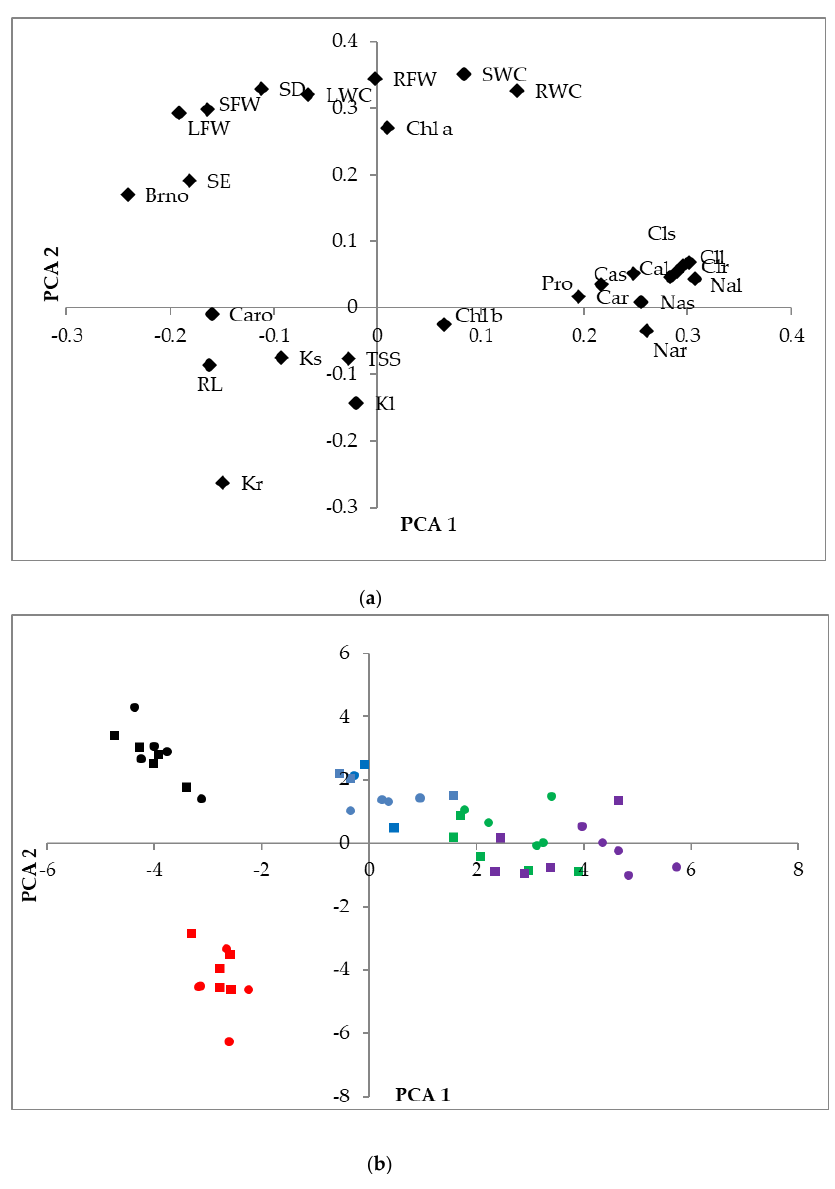
Figure 8. Loading plots of the Principal Component Analysis (PCA) ( a ), conducted with the analyzed traits in L. angustifolia (var. ‘Codreanca’ and var. ‘Sevtopolis’), subjected to salt and water stress conditions for 30 days, based on the first and second components accounting for 36.5% and 23.9%, respectively, of the total variability observed. RL, root length; SE, stem elongation; SD, stem diameter increment; Bno, increment in the number of branches; RFW, root fresh weight; RWC, root water content; SFW, stem fresh weight; SWC, stem water content; LFW, leaf fresh weight; LWC, leaf water content; Chl a, chlorophyll a; Chl b, Chlorophyll b; Caro, total carotenoids; Nar, sodium in roots; Clr, chloride in roots; Kr, potassium in roots; Car, calcium in roots; Nas, sodium in stems; Cls, chloride in stems; Ks, potassium in stems; Cas, calcium in stems; Nal, sodium in leaves; Cll, chloride in leaves; Kl, potassium in leaves; Cal, calcium in leaves; Pro, proline; TSSs, total soluble sugars. Scatter plot of the PCA scores ( b ): Control (black symbols), water stress (red), 100 mM NaCl (blue), 200 mM NaCl (green), and 300 mM NaCl (violet); LAC variety (circles); LAS (squares).